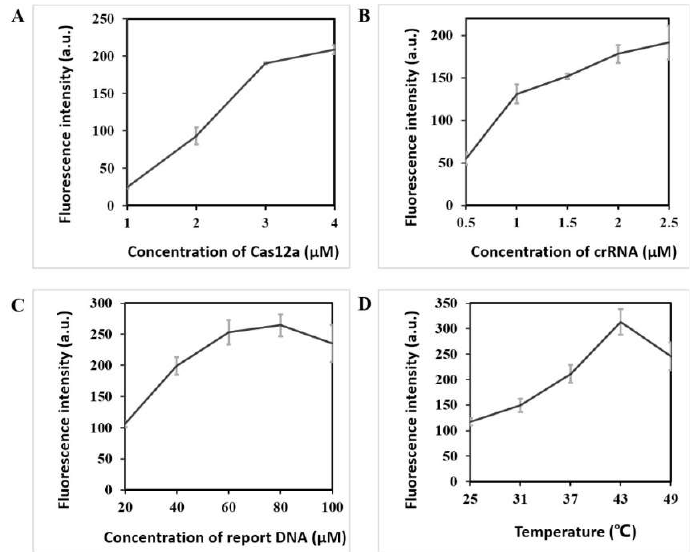
Figure 2. Optimization of LAMP–CRISPR detection system for Salmonella detection. ( A ) Fluorescence intensity using different concentrations (1, 2, 3, and 4 μM) of Cas12a; ( B ) Fluorescence intensity using different concentrations (0.5, 1.0, 1.5, 2.0, and 2.5 μM) of crRNA; ( C ) Fluorescence intensity using different concentrations (20, 40, 60, 80, and 100 μM) of report DNA; ( D ) Fluorescence intensity under different temperatures (25 °C, 31 °C, 37 °C, 43 °C, and 49 °C) of CRISPR/Cas12a system.